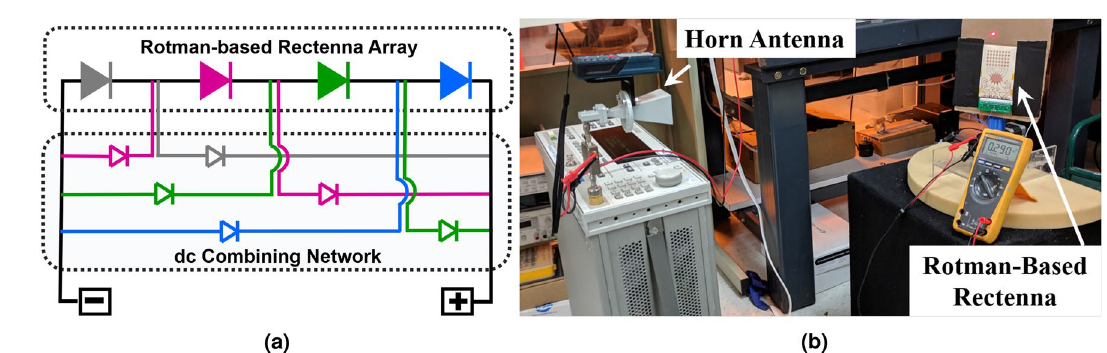
Figure 5. ( a ) Rotman-based rectenna power summation network and ( b ) picture of the setup used to measure the angular response of the